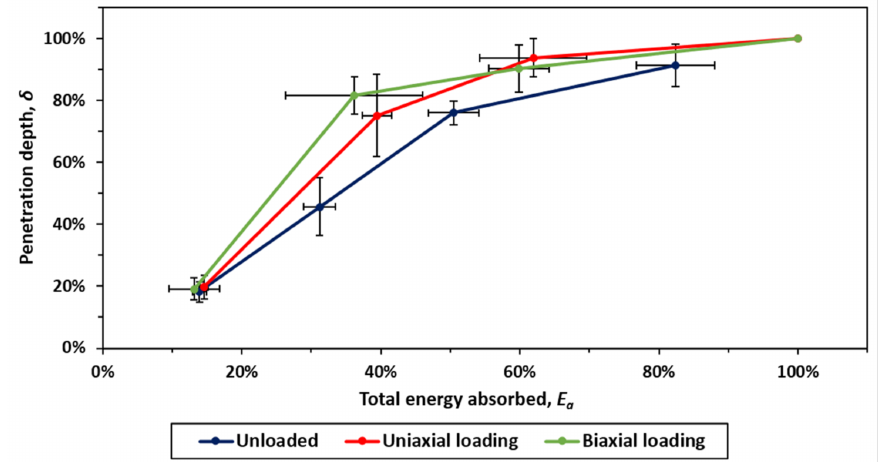
Figure 17. Penetration depth, δ , against mean absorbed energy, E a , for three different loading condi- tions: unloaded, uniaxial loading and biaxial loading. Here, 100% penetration depth corresponds to the laminate through-thickness (1.85